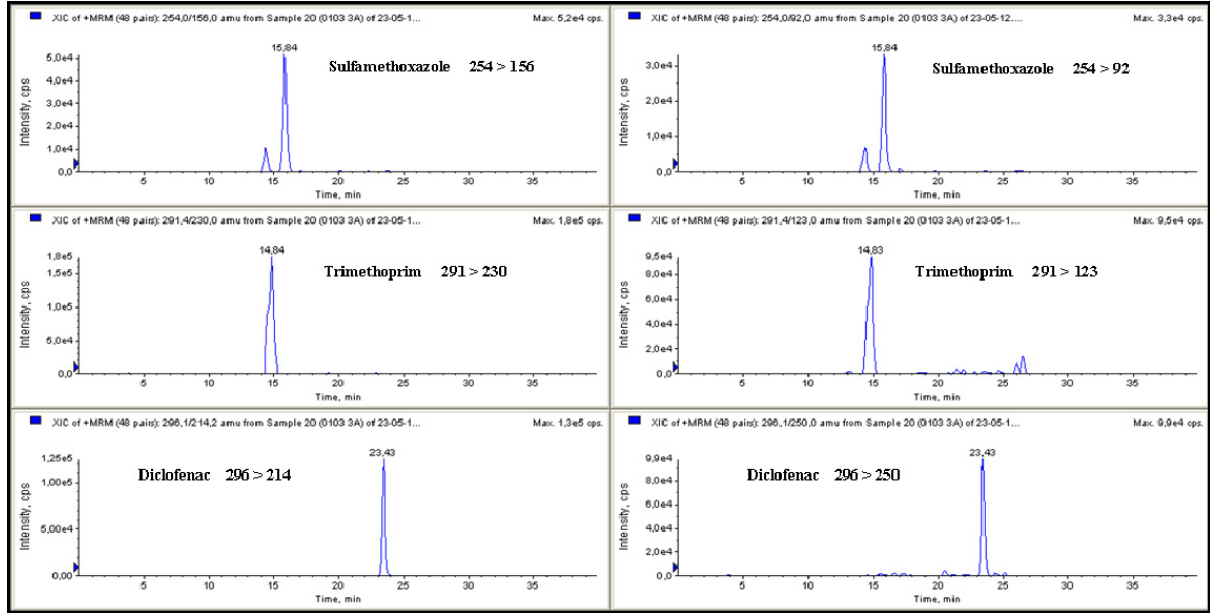
Figure 2. MRM chromatograms for sulfamethoxazole (37.7 ng·L − 1